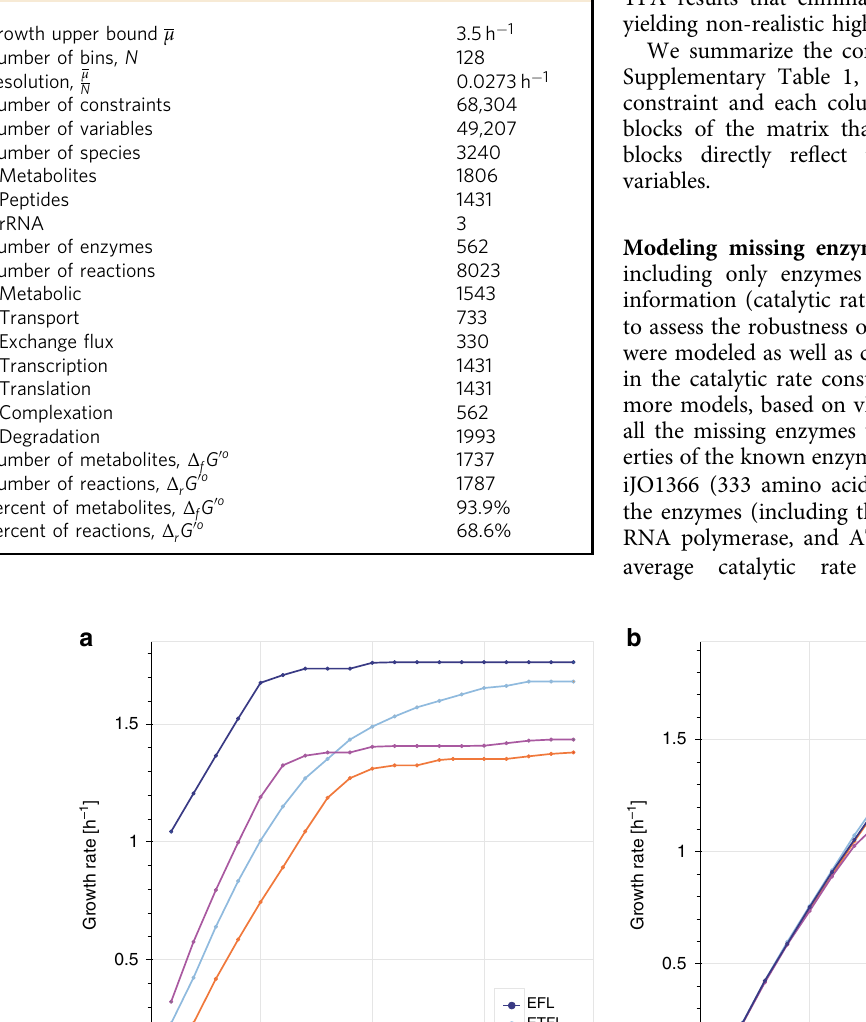
Table 3 Properties of the vETFL model generated from iJO1366.